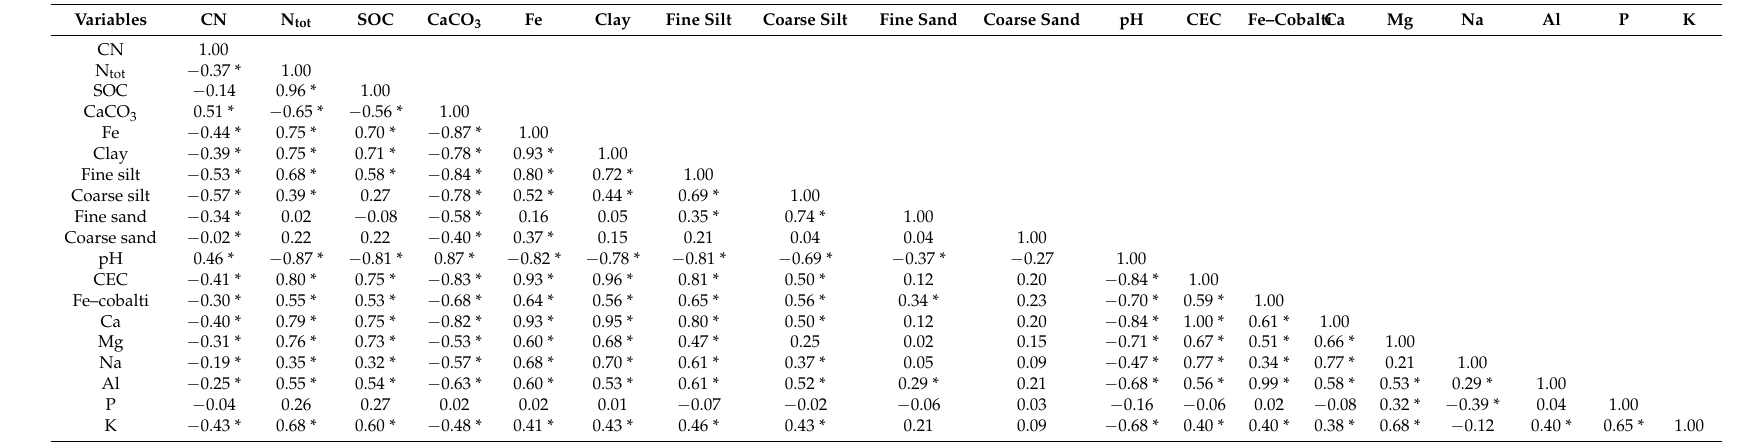
Table 6. Pearson correlation table of the nutrient properties of the pits’ horizons (48